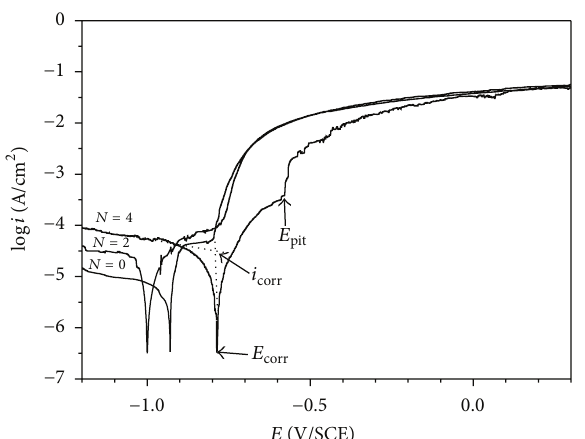
Figure 5: Potentiodynamic polarization curves obtained at 25 ∘ C and 10mV/s with the nonpressed ( 𝑁 = 0 ) and ECAP’ed ( 𝑁 = 2 and 4) samples in solution of 3.5 wt.% NaCl solution at pH 6.4.